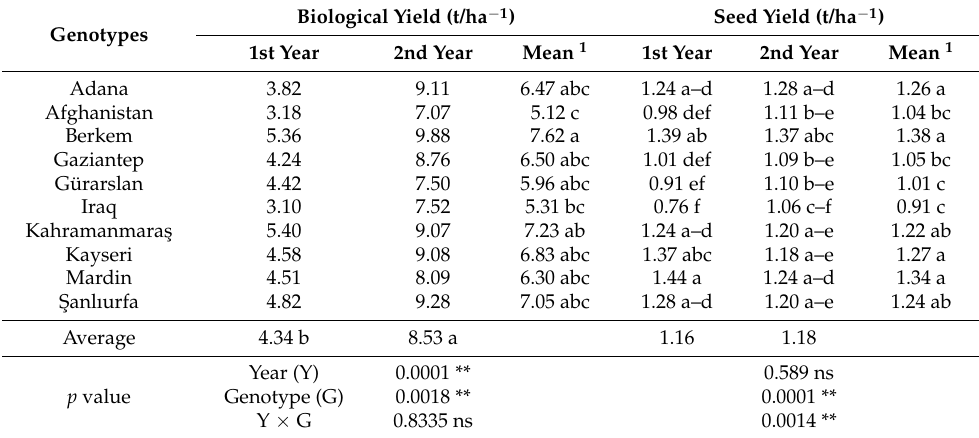
Table 6. Average values for biological yields and seed yields of fenugreek genotypes.